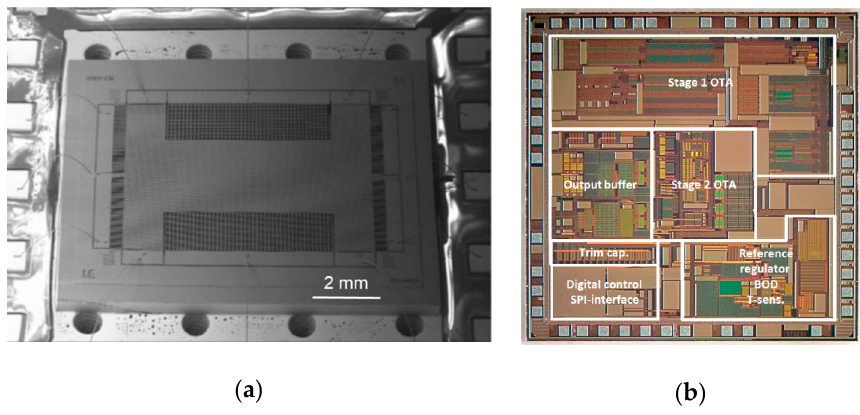
Figure 12. Images of the MEMS accelerometer and the readout ASIC developed by Utz et al. at Fraunhofer Institute for Microelectronic Circuits and Systems [55]: ( a ) SEM image of the MEMS accelerometer; ( b ) photograph of the readout ASIC.